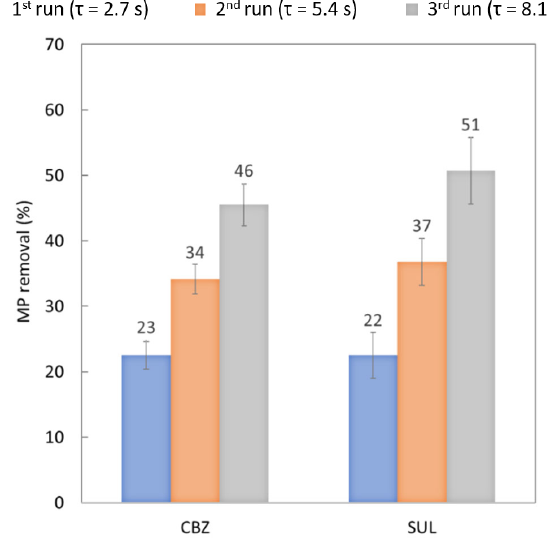
Figure 8. Percent removal of MPs calculated from the inlet concentration before the 1st run of experiments with recirculating water with an ozone concentration at the gas-phase inlet of 15 g.Nm − 3 , a liquid flow-rate of 47.8 L.h − 1 and a gas flow-rate of 8 L.h − 1 at neutral pH.